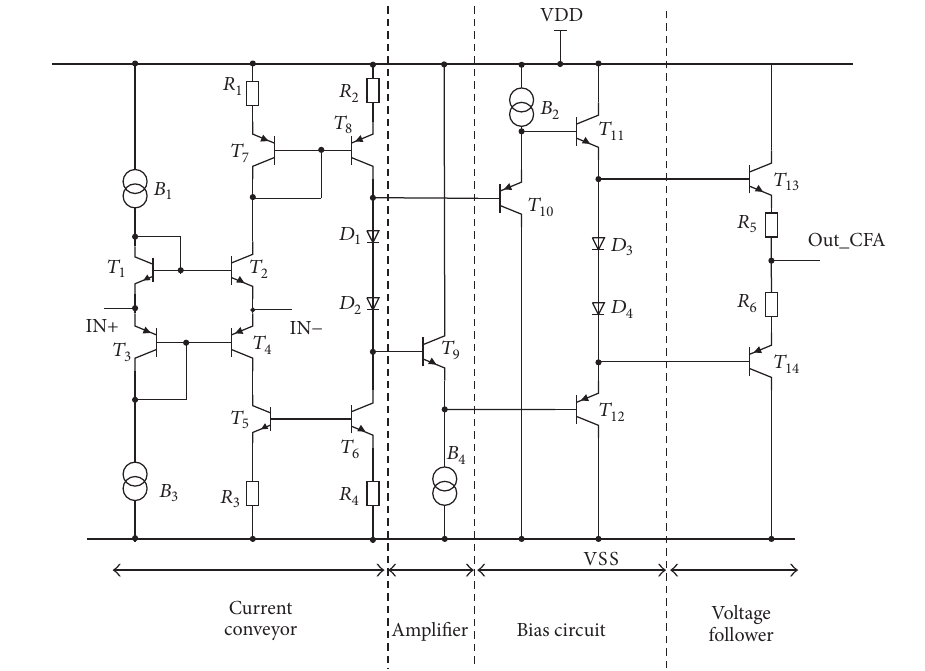
Figure 6: CFA circuit structure.